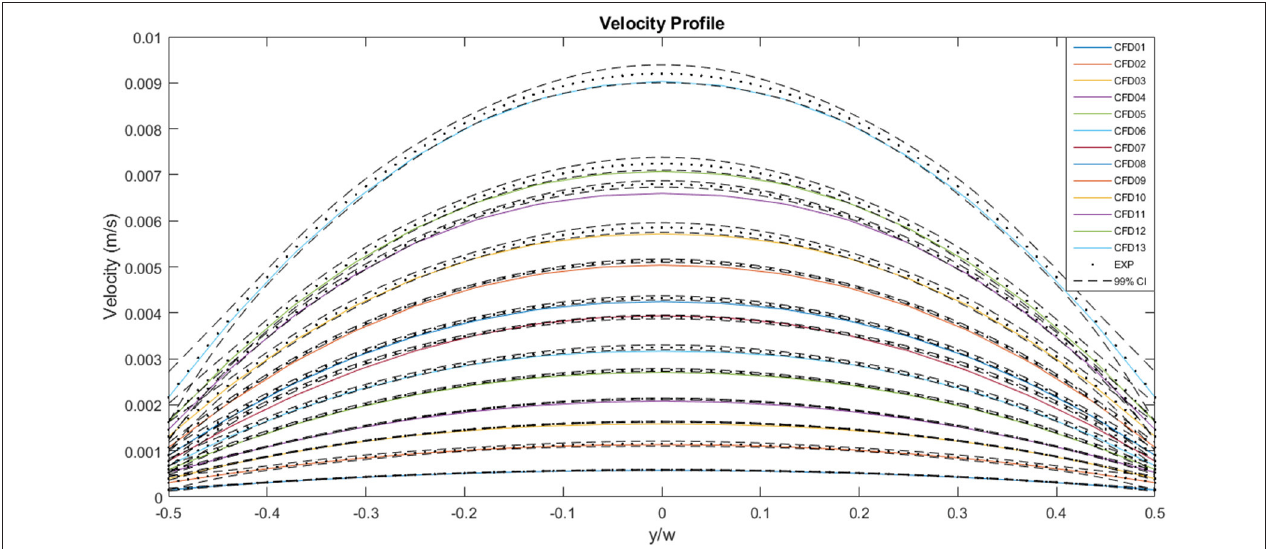
FIGURE 9 | A comparison between the experimentally measured and computationally predicted flow velocities across the channel width at the mid-plane, for a range of flow rates. The solid lines represent CFD values, the dots represent experimental values and the dashed lines indicate the 99% confidence interval for those experimental values.